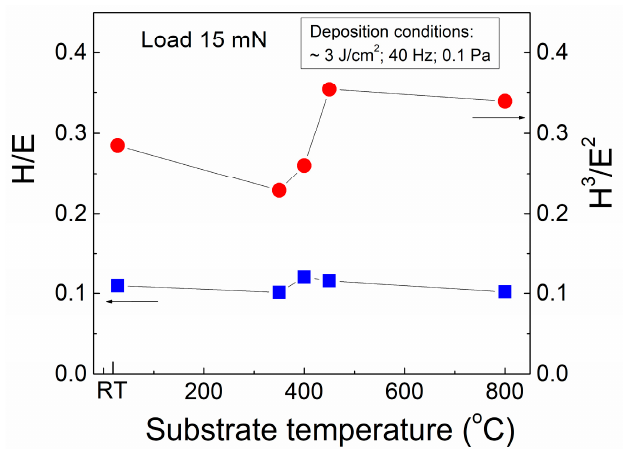
Figure 4. Resistance for elastic strain to failure ( H / E ) and plastic deformation ( H 3 / E 2 ) of the PLD AlN films as a function of substrate temperature during deposition.